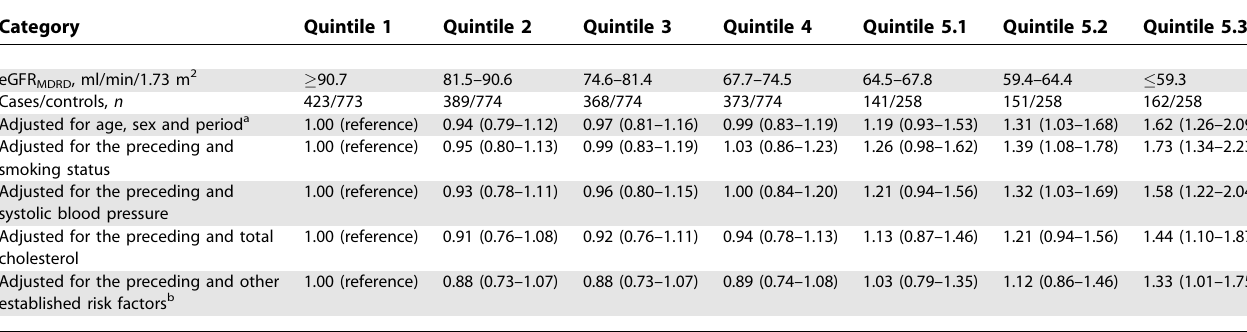
Table 3. Relative Odds (95% CI) of CHD According to eGFR MDRD